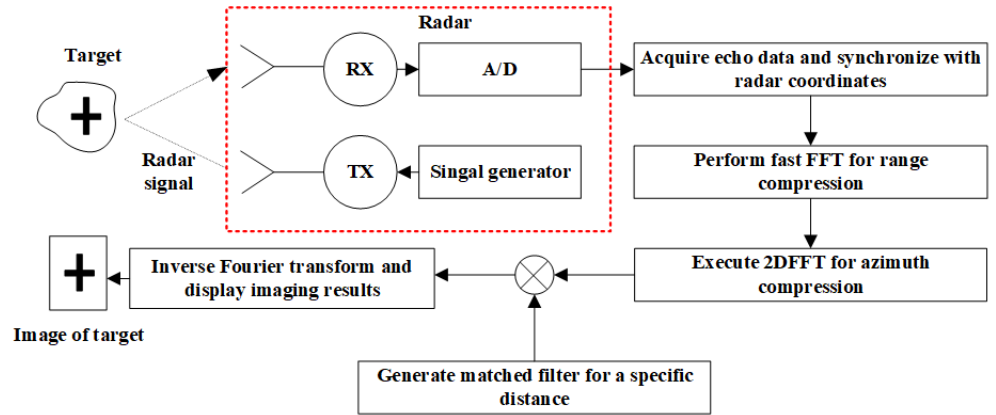
Figure 2. Flowchart of matched filter reconstruction for near-field SAR image; The red box shows the schematic diagram of the radar